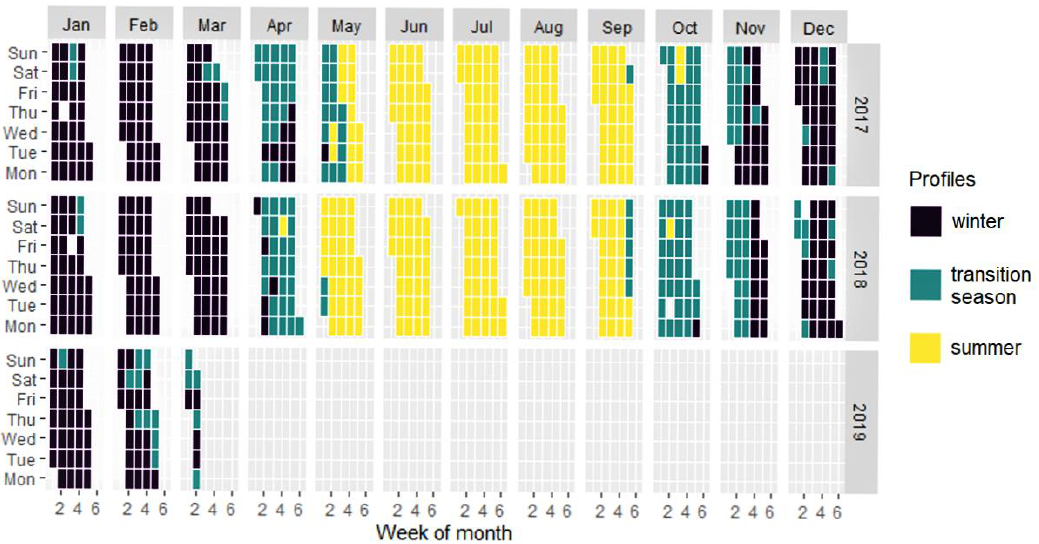
Figure 8. The distribution of three seasonal load profiles of the case study building.